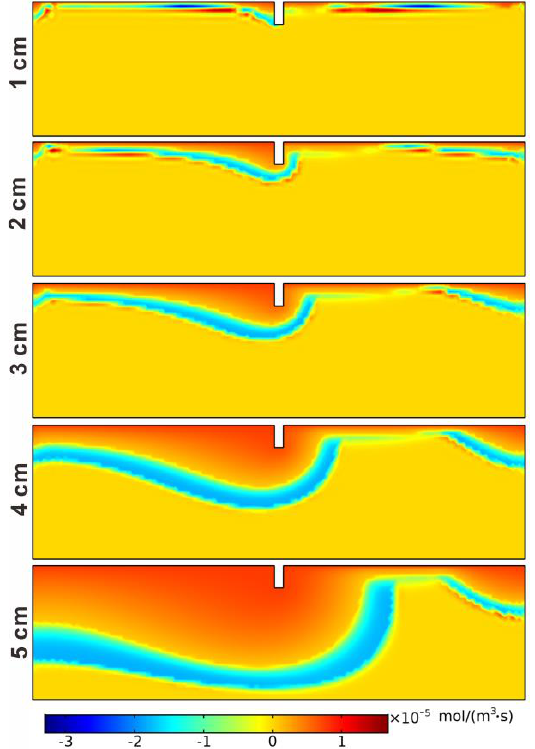
Figure 7. The reaction rates of net denitrification in the five different height cases.